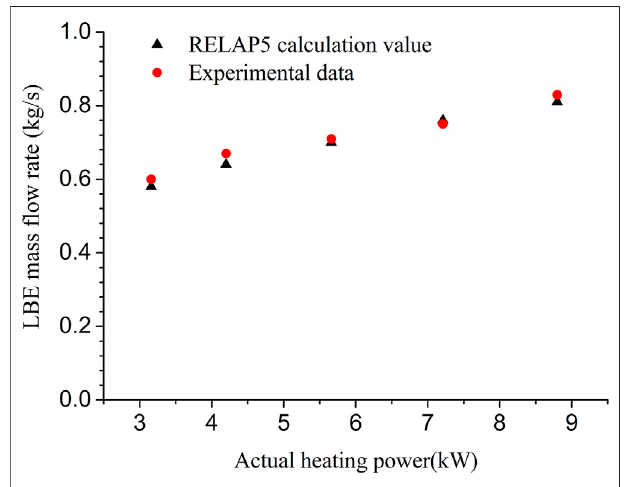
FIGURE 8 | Comparison of the LBE mass fl ow rate under different heating power levels.